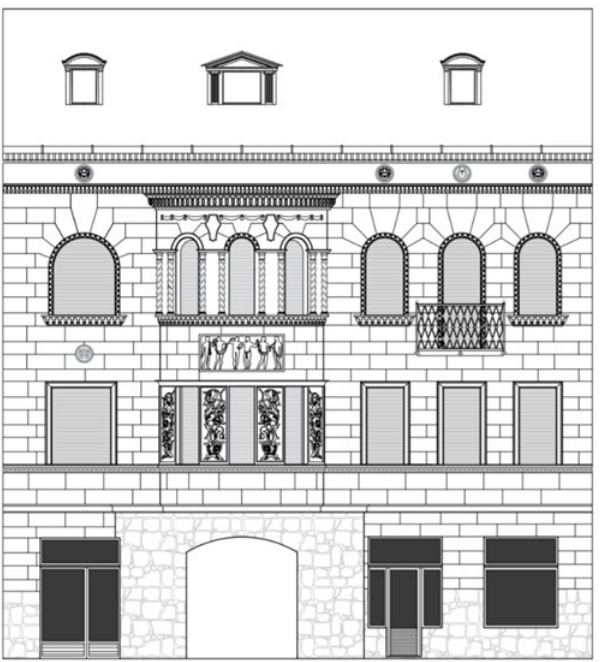
Figure 3. Two-dimensional survey of the facade of the Heyman House in Oradea, obtained by the cartographic method. cartographic